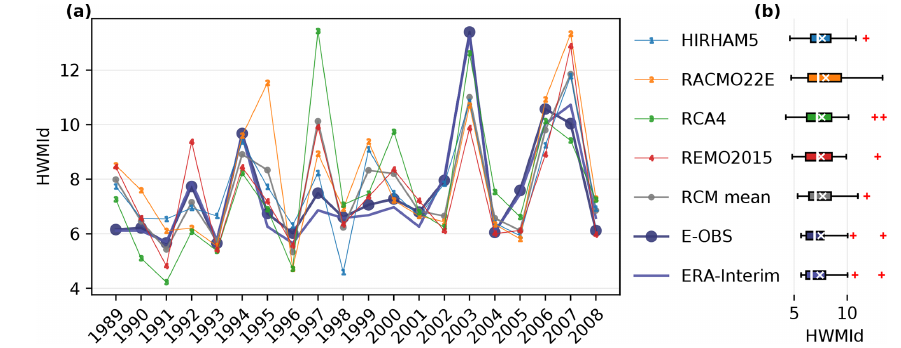
Figure 2. Regional mean HWMId from 1989 to 2008 in the four RCM evaluation runs, the multi-RCM mean, E-OBS, and ERA-Interim: (a) temporal evolution, and (b) corresponding box-plot. In each box-plot, the box limits represent lower and upper quartiles, the white line and “x” marker inside the box are the median and the mean, respectively and the outliers marked with red plus signs outside of the whiskers lie at least 1.5 times the IQR away from the box limits. Table 3. Similar to Table 2 but with temporal measures for the time series of regional mean HWMId from 1989–2008 (corresponding to Fig. 2). ERA-Interim HIRHAM5 RACMO22E RCA4 REMO2015 RCM mean MBE −